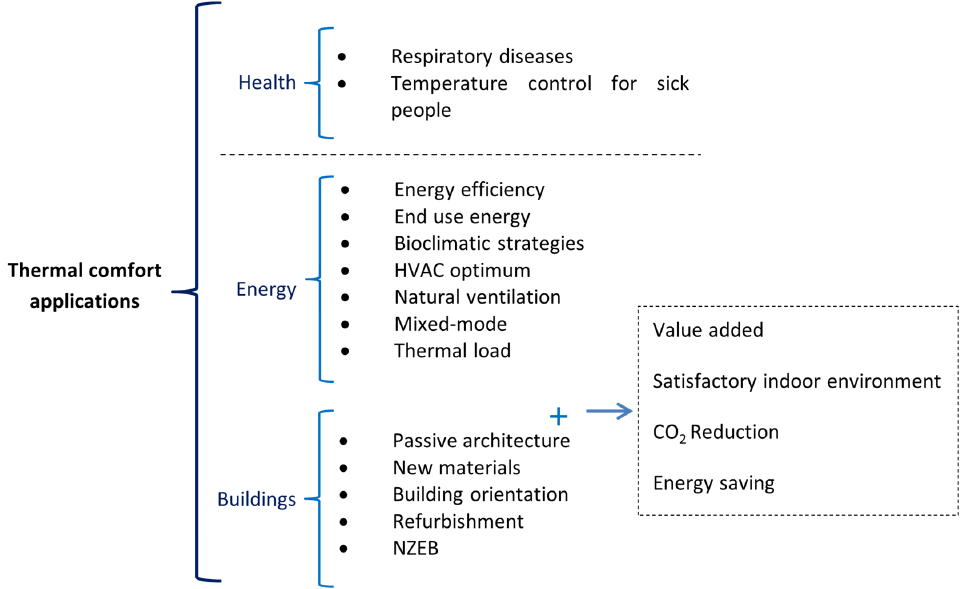
Figure 1. Thermal comfort applications (HVAC: heating, ventilation and air conditioning. NZEB: near zero energy building).